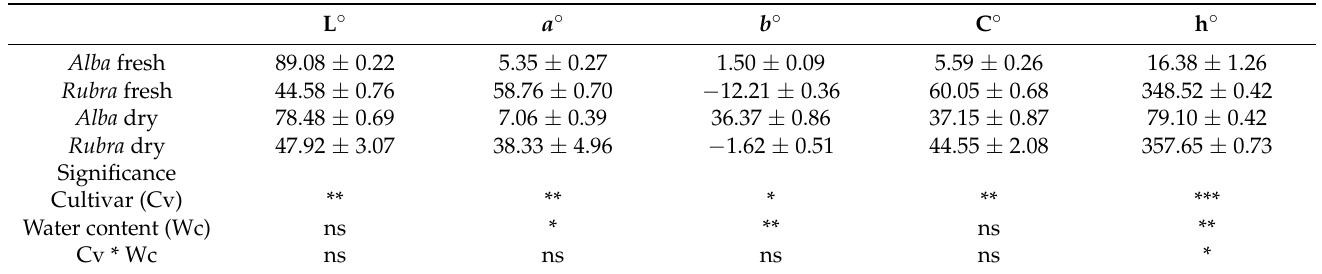
Table 2. CIELab coordinates (lightness, redness/greenness, yellowness/blueness, and chroma), and hue angle of fresh and dry petals from Rosa rugosa cv. Alba and cv.